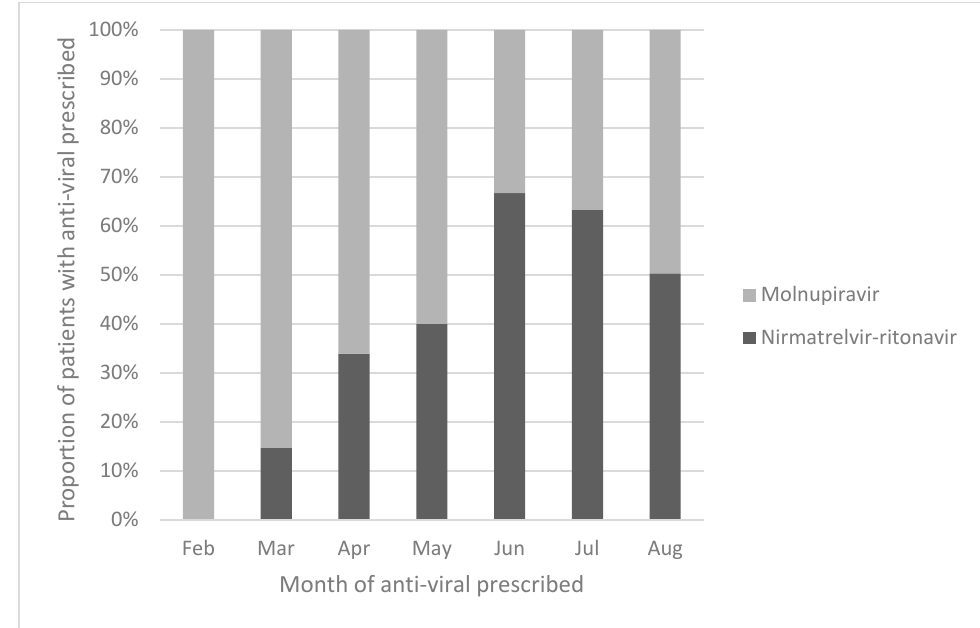
Figure 1. Proportion of patients prescribed nirmatrelvir–ritonavir and molnupiravir in this cohort.